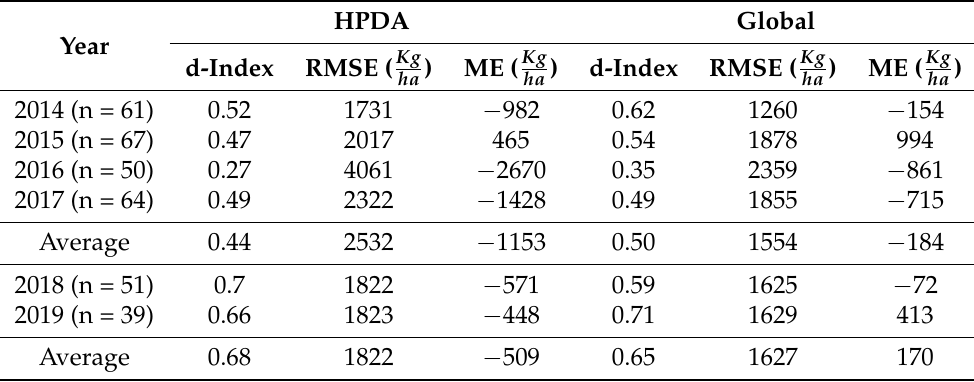
Table 3. Comparing model performance in simulating crop yield on out of sample sites for outside (2014–2017) and within the (2018–2019) the spatiotemporal extent of training